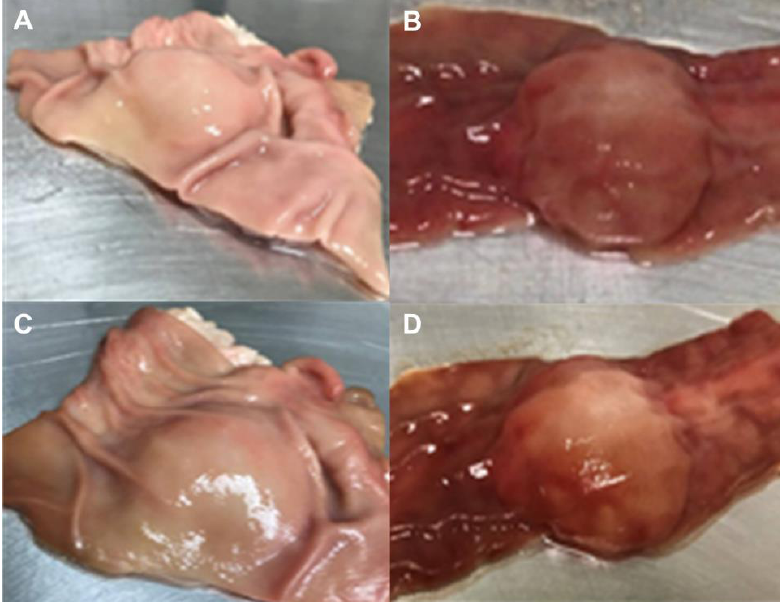
Figure 5. Submucosal elevation; ( A ) porcine stomach just after injection; ( B ) porcine colon just after injection; ( C ) porcine stomach 90 min after injection; ( D ) porcine colon 90 min after injection.